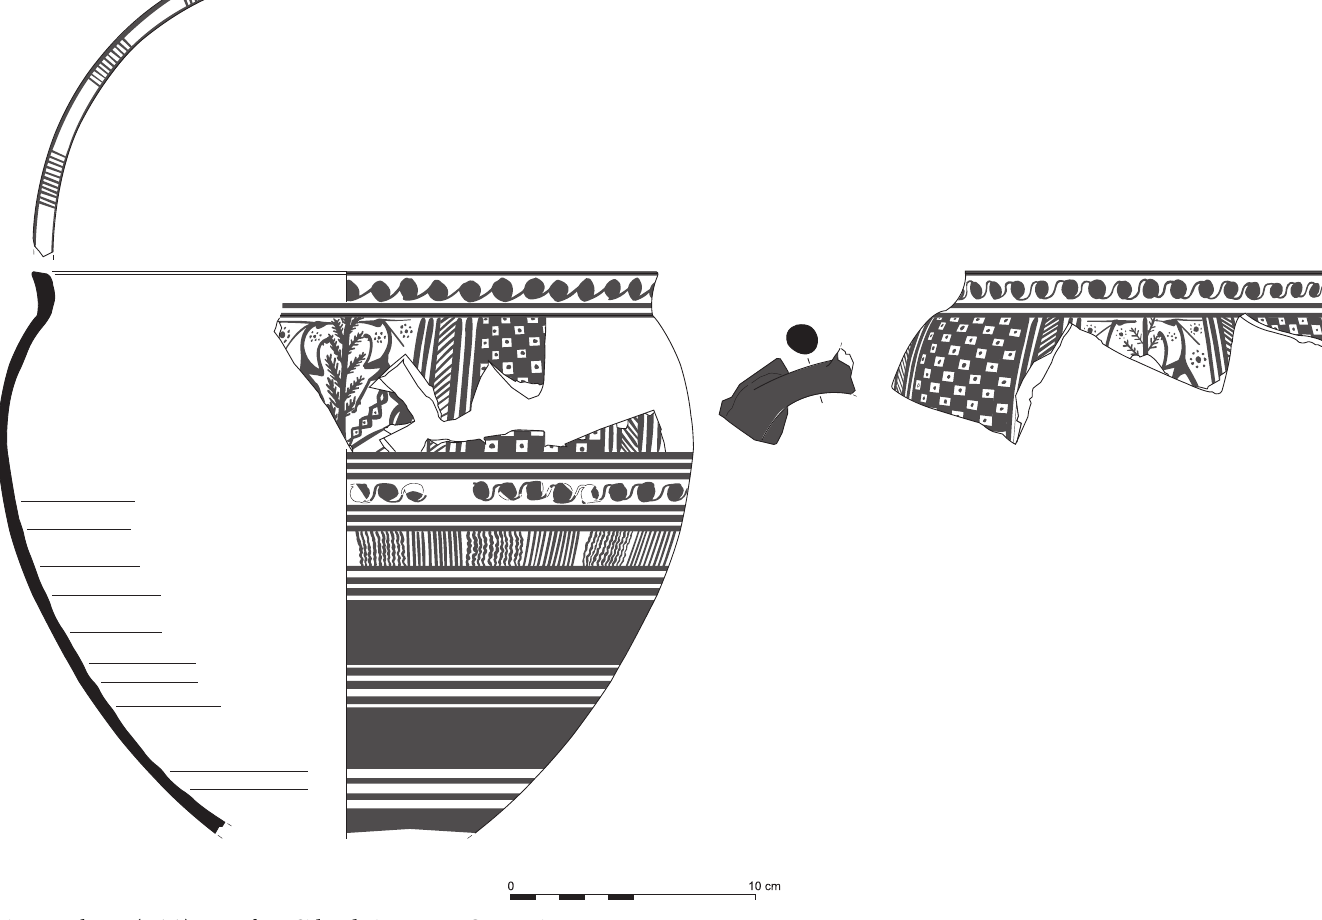
Fig 33. Euboean (NAA) crater from Sidon dating to Late Geometric